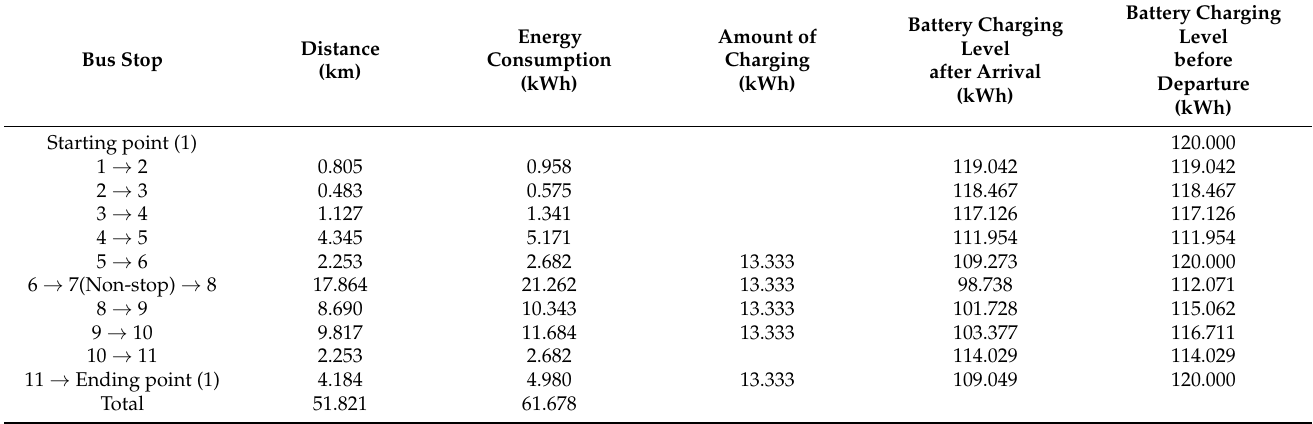
Table 3. Distance, energy consumption, amount of charging, and battery charging level for each stop.